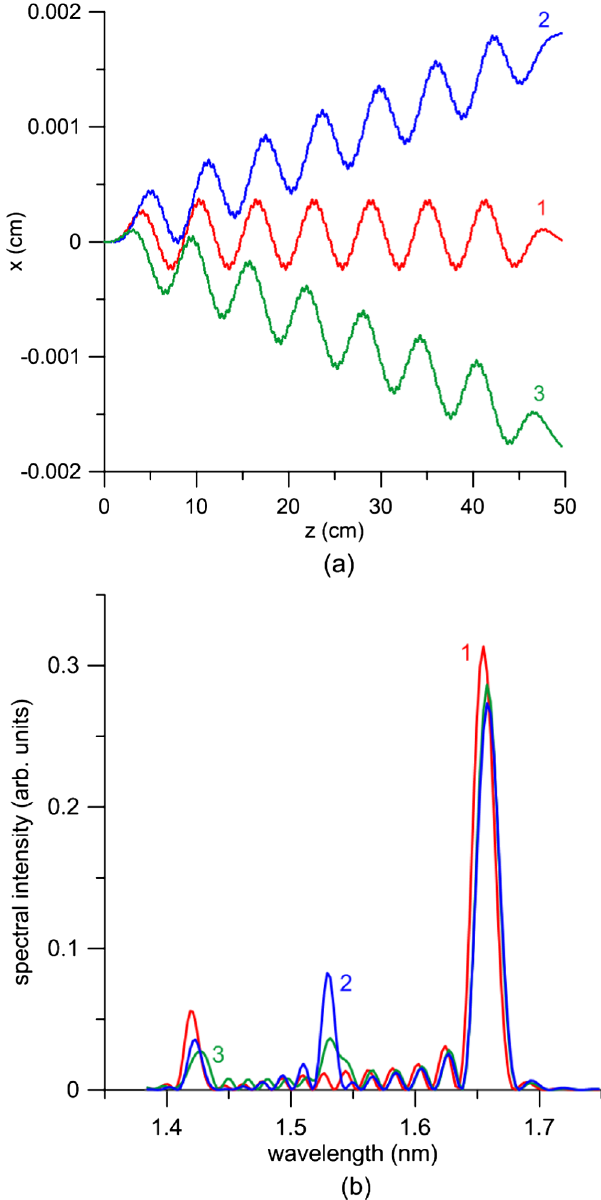
FIG. 5. Motion of test electrons in a tapered SW undulator with different injection phases with respect to the optimized phase ( K ¼ 0 : 4 ): (a) trajectories of particles; (b) radiated spectra. (1) (cid:1) ’ ¼ 0 (cid:11) ; (2) (cid:1) ’ ¼ (cid:5) 45 (cid:11) ; and (3) (cid:1) ’ ¼ þ 45 (cid:11) [Fig. 5(b)] in the tapered undulator is not improved in comparison with spectrum quality in Fig. 3 (curve 2) for the untapered case. Note that data in Fig. 5(a) are normal- ized with the same coefficient like data in Fig. 3.